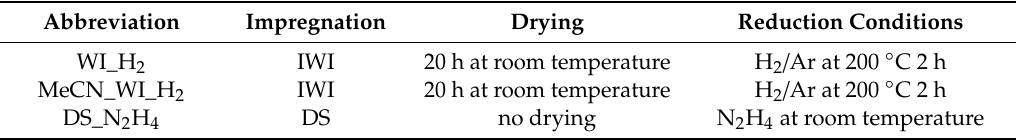
Table 1. Methods of immobilization of Ag and Pd in UiO-66.